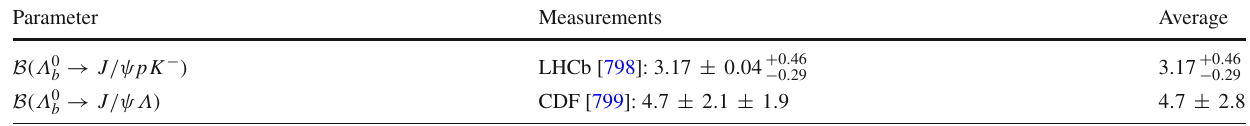
Table 209 f b times Λ 0